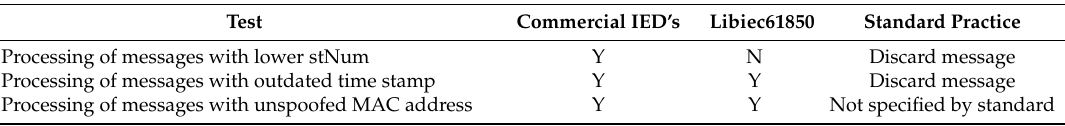
Table 1. Compliance Test